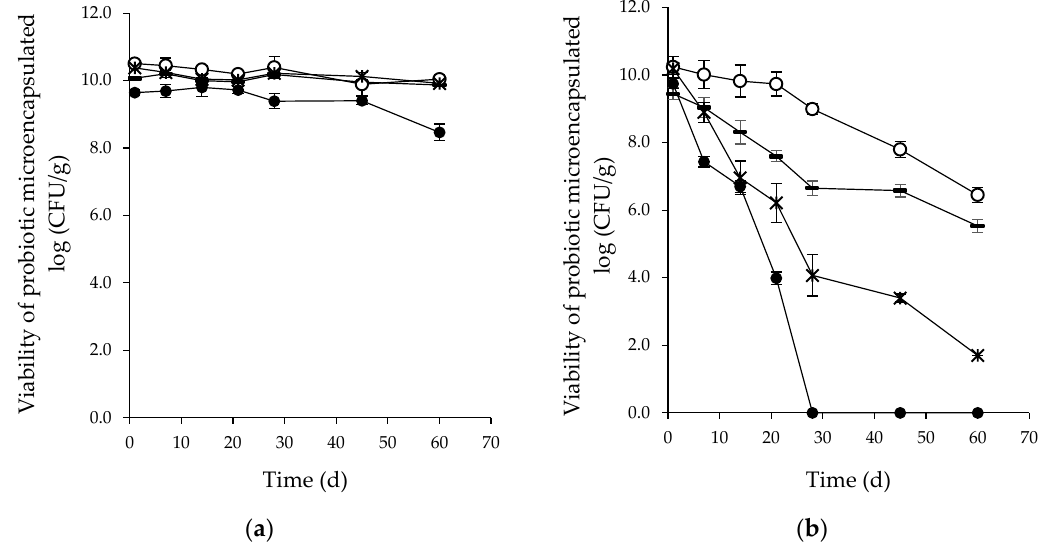
Figure 3. Viability during storage of probiotics encapsulated by spray drying with 0.6% w/v of chia seed mucilage (CM) in the encapsulating solution at 90 °C: ( a ) 4 °C and ( b ) 25 °C. ( ▬ ) L. plantarum , ( ◦ ) B. infantis , ( ∗ ) B. longum , and ( • ) L. rhamnosus .